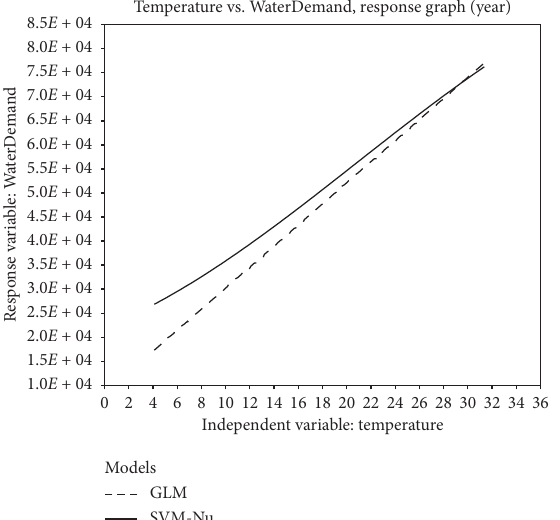
Figure 10: The reaction of water consumption to air temperature with summer conditions using GLM and SVM-Nu